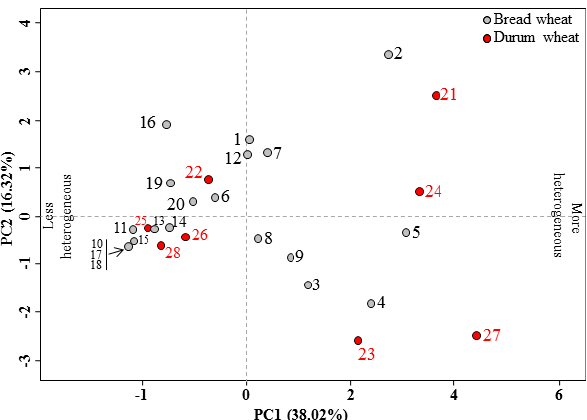
Figure 3. Plot of the first (PC1) and second (PC2) principal com- ponent means from an analysis of the 11 variables (percentage of resistant plants in susceptible landraces and percentage of suscep- tible plants in resistant landraces, for each of the 11 Puccinia strii- formis f. sp. tritici pathotypes, for 28 Lebanese landraces (1-28)), as described in Table 7. Gray symbols = bread wheat, red symbols = durum wheat.